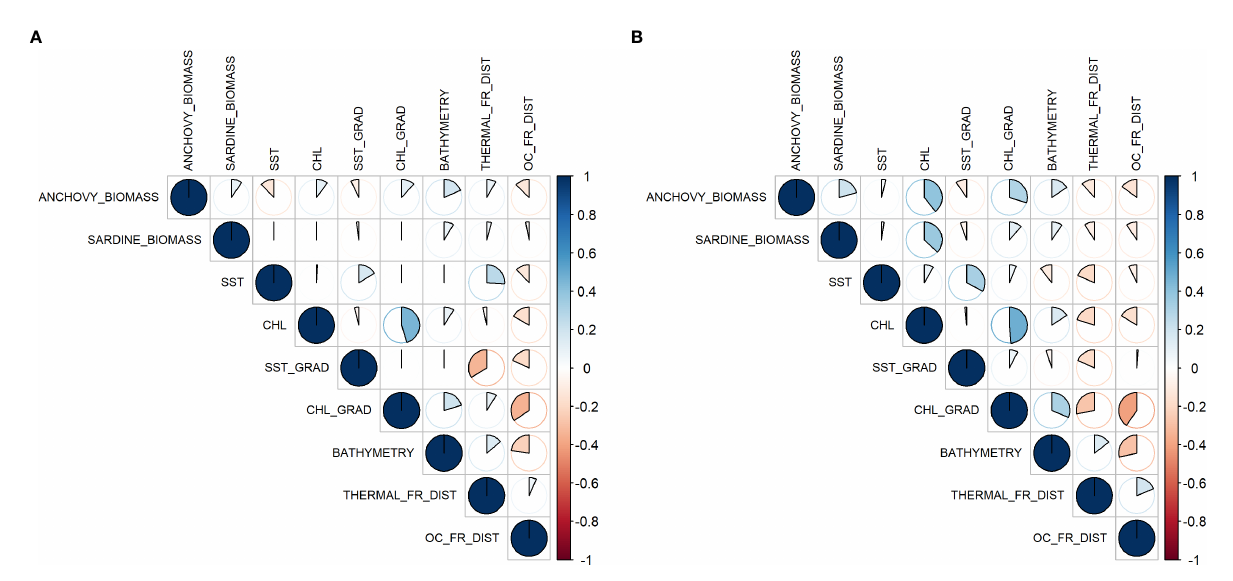
FIGURE 3 Correlation plot between anchovy and sardine biomass and the independent variables for (A) the TS dataset and (B) the GT